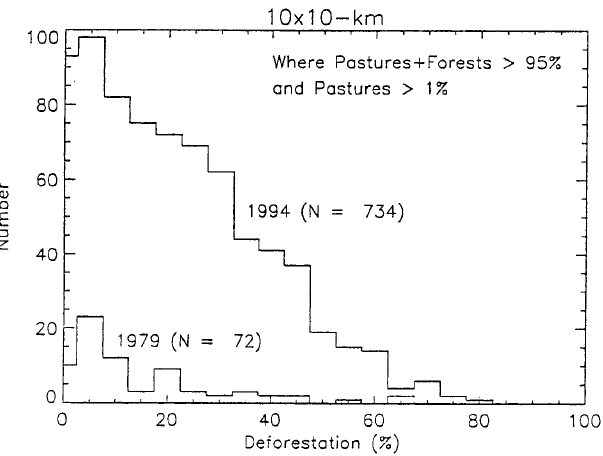
Fig. 3. Histogram of the deforestation rate in 1993–1994 as calculated for a 10 km · 10 km grid from the 120-m pixel size map produced over the 8–13 S, 60–65 W domain. The histogram obtained for 1979 from the RADAMBRASIL maps (Calvet et al ., 1997) is also plotted